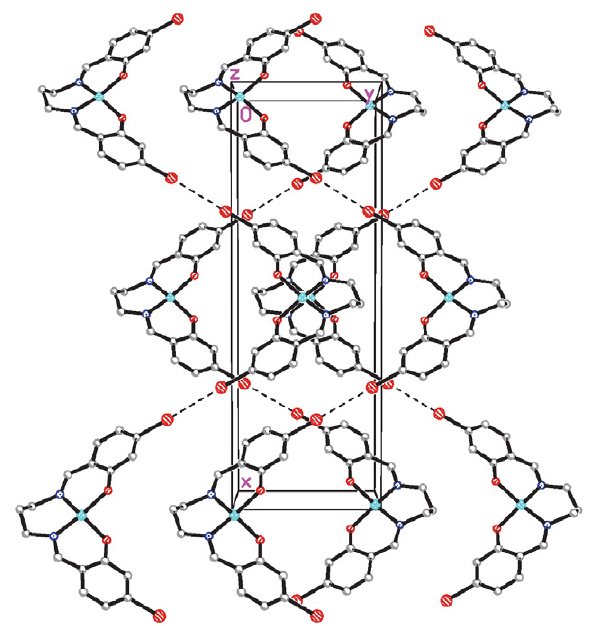
Fig. 2. Packing structure for complex 1 viewed along the z axis. Dashed lines represent Br···Br interactions forming zigzag chains along the x axis.